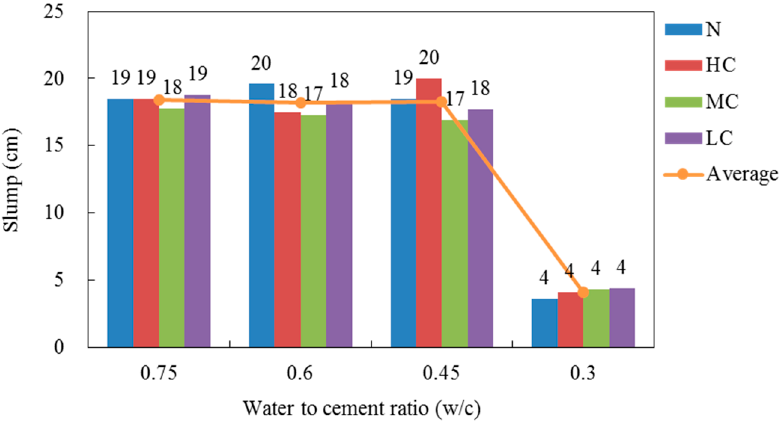
Figure 5. Slump of fresh concrete with different water-to-cement ratios. N: natural aggregate concrete; HC: high-quality recycled aggregate concrete; MC: medium-quality recycled aggregate concrete; LC: low-quality recycled aggregate concrete.